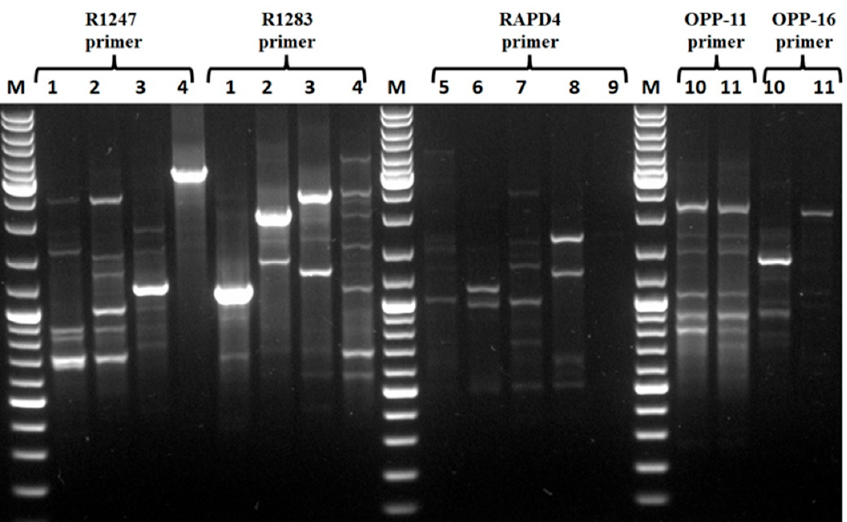
Figure 1. RAPD analysis of clinical Gram-negative strains, using R1247 and R1283 primers for E. coli strains: E coli 184 (1), E coli H45 (2), E. coli H51 (3), E. coli H66 (4), RAPD4 primer for Klebsiella strains: K. oxytoca H40 (5), K. pneumoniae H71 (6), K. variicola H77 (7), K. pneumoniae H79 (8), K. pneumoniae H79 (9), OPP-11 and OPP-16 for Salmonella strains: S. enterica Enteritidis H10 (10), S. enterica Typhimurium H97 (11).